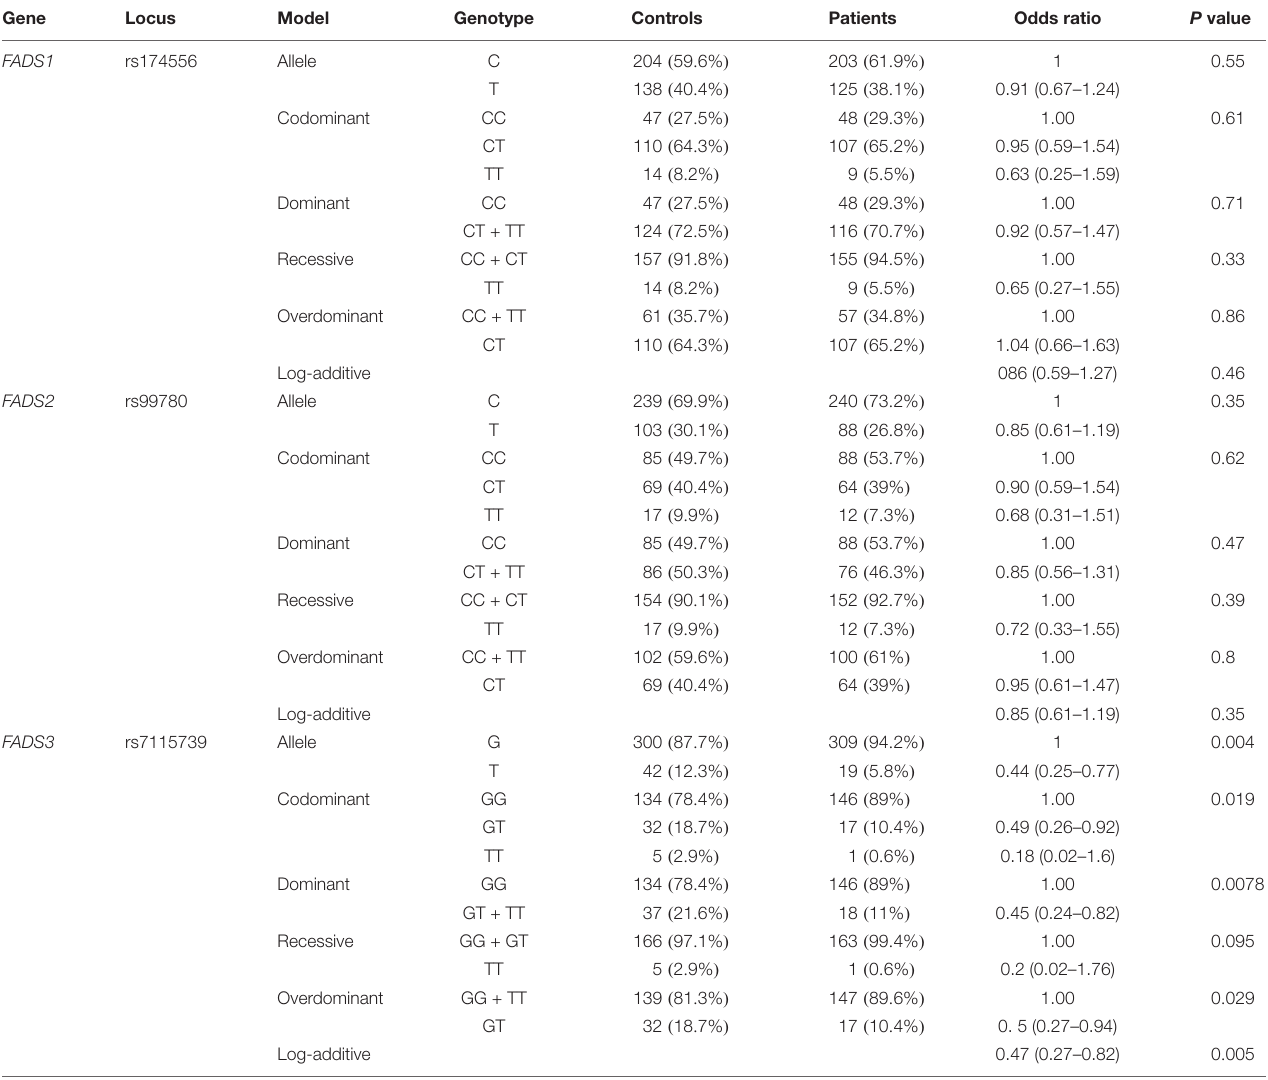
TABLE 4 | Results of association between FADS1 – 3 polymorphisms and ESRD. Gene Locus Model Genotype Controls Patients Odds ratio